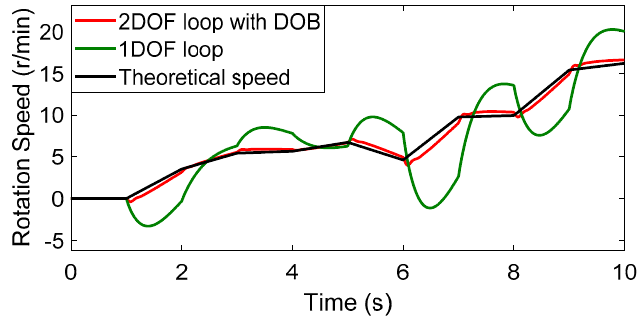
Figure 12. Speed response under different control modes.